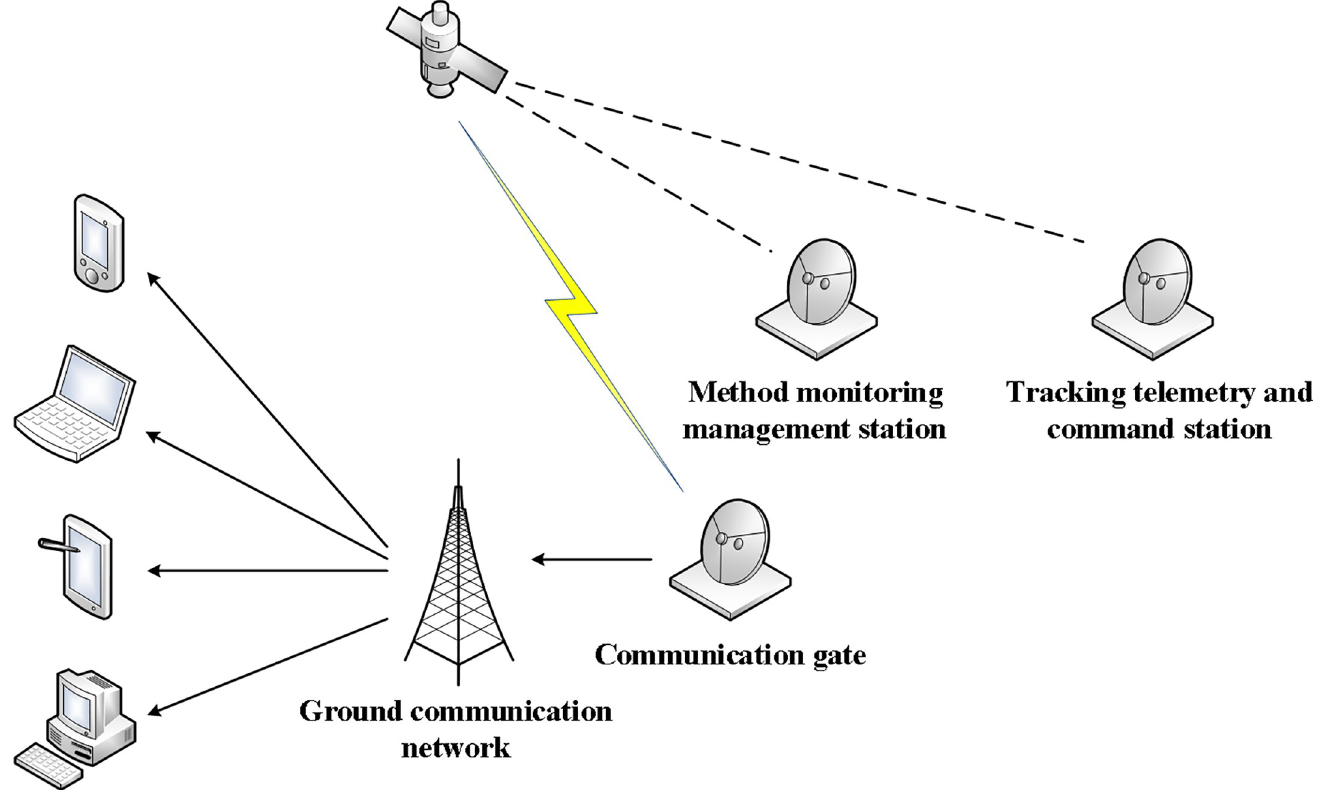
Fig 1. Broadband satellite communication